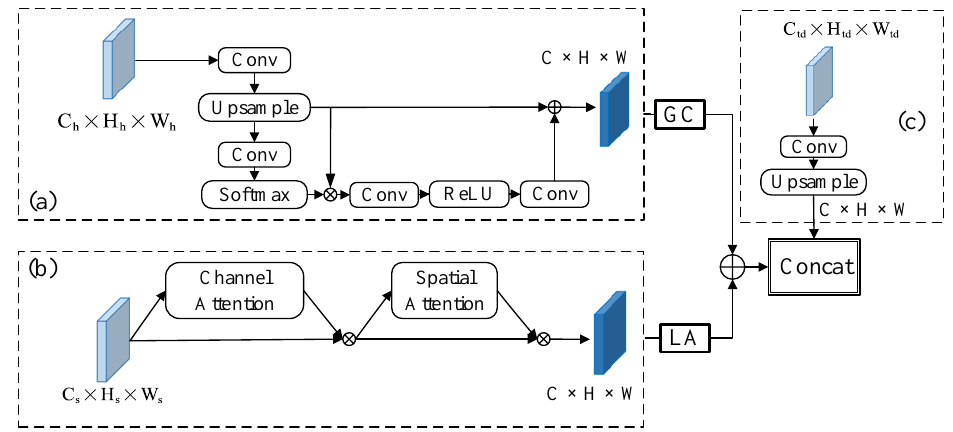
Figure 7. Illustration of the CAA module. ( a ) High-level feature maps use GC attention; ( b ) Low-level feature maps use CBAM attention; ( c ) Top-down feature information F td